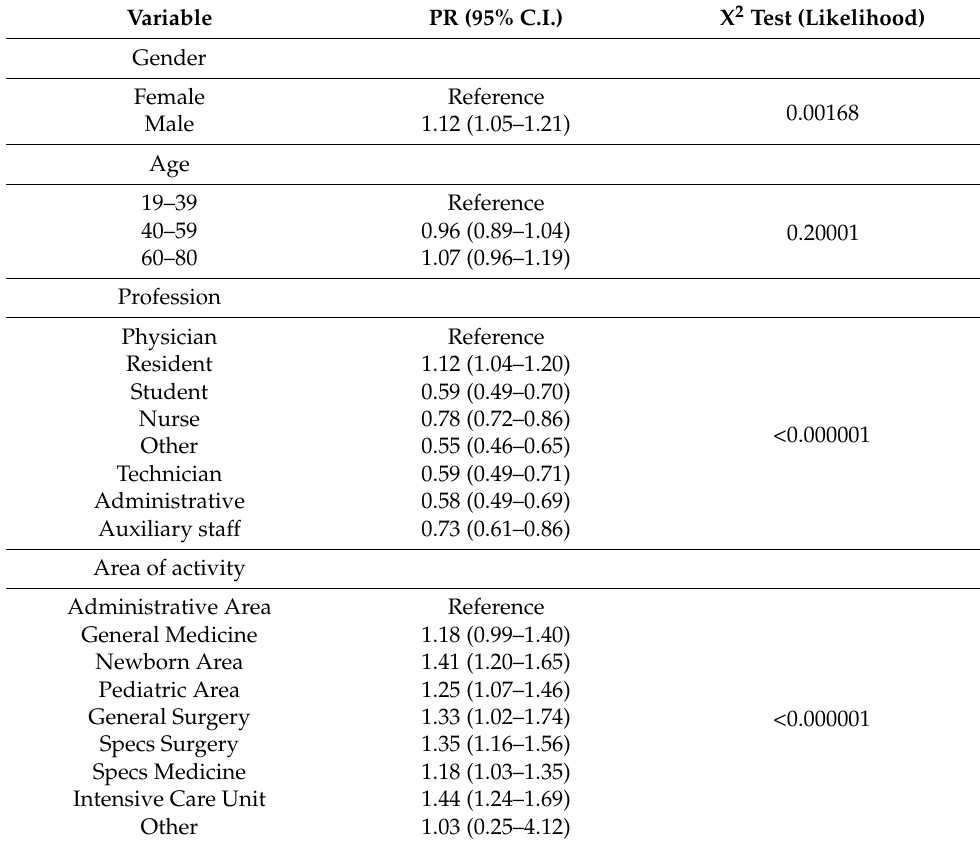
Table 3. Prevalence ratio of never vaccinated before versus vaccinated before 2020. Variable PR (95% C.I.) X 2 Test (Likelihood) Gender